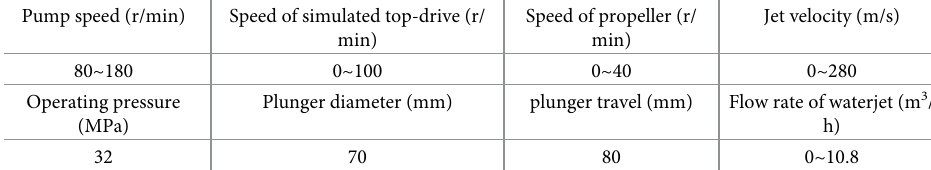
Fig 11. Particle jet coupled impact rock-breaking device in rotary drilling. https://doi.org/10.1371/journal.pone.0250588.g011 Table 3. The experimental